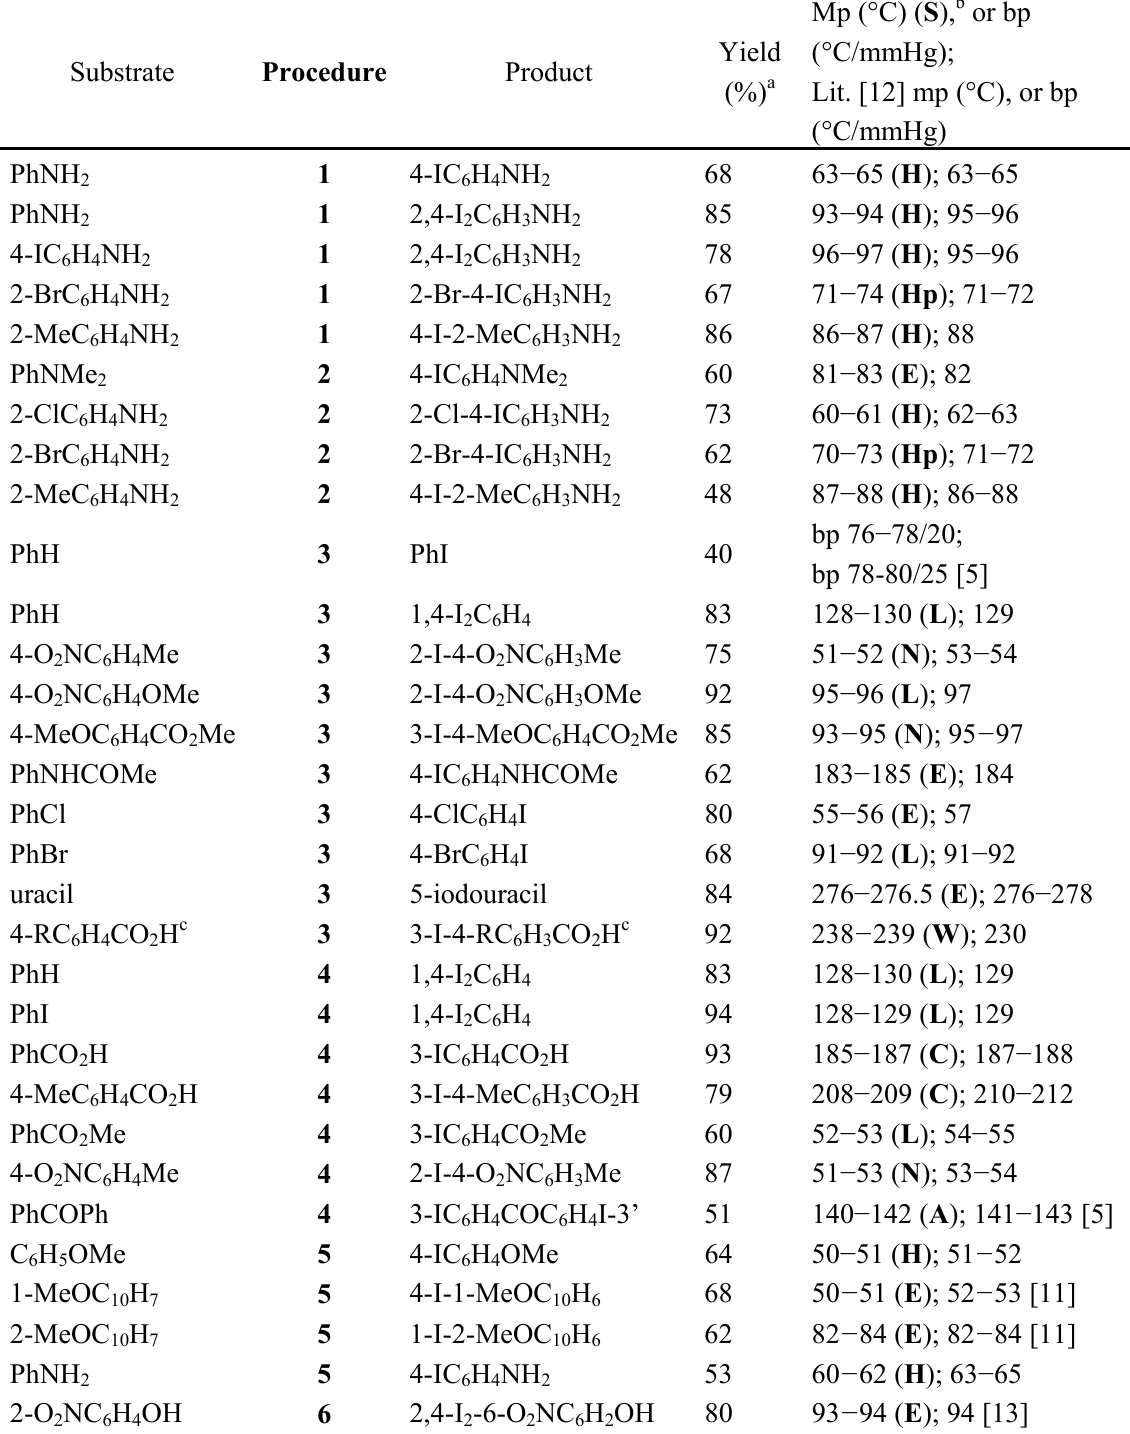
Table 1. Iodinated Pure Products